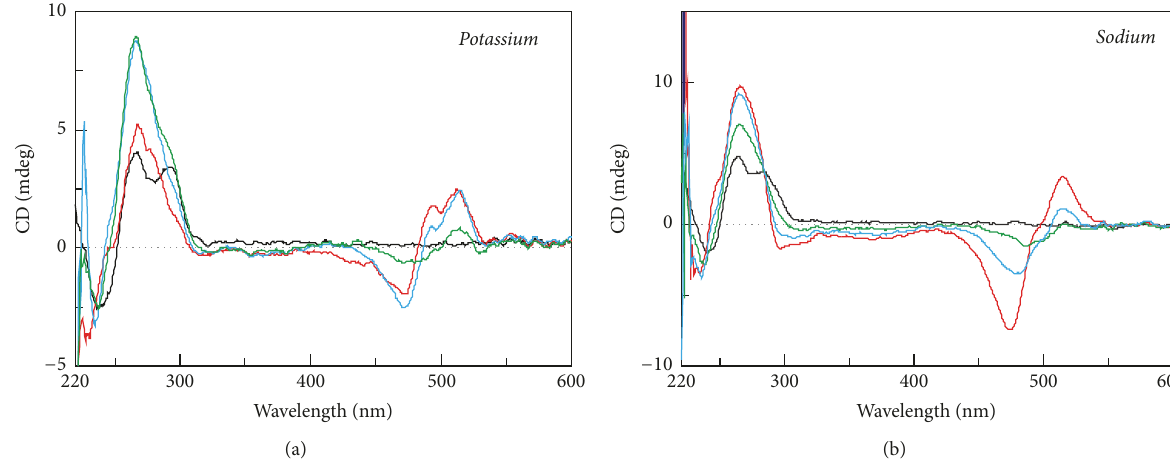
Figure 7: The representative CD titration spectra of ∼ 27 𝜇 M H1-JN with TO. 0, 2.5, 5, and 7.5 molar equivalents of TO represent black, green, blue, and red lines, respectively. Each sample was measured in modified 25 mM Britton-Robinson containing (a) 50 mM KCl and (b) 50mM KCl.